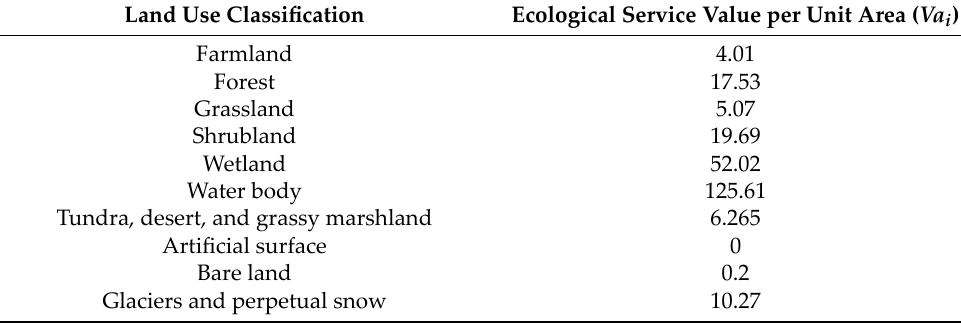
Table 1. Ecological service value per unit area ( Va i ) of different land use types.